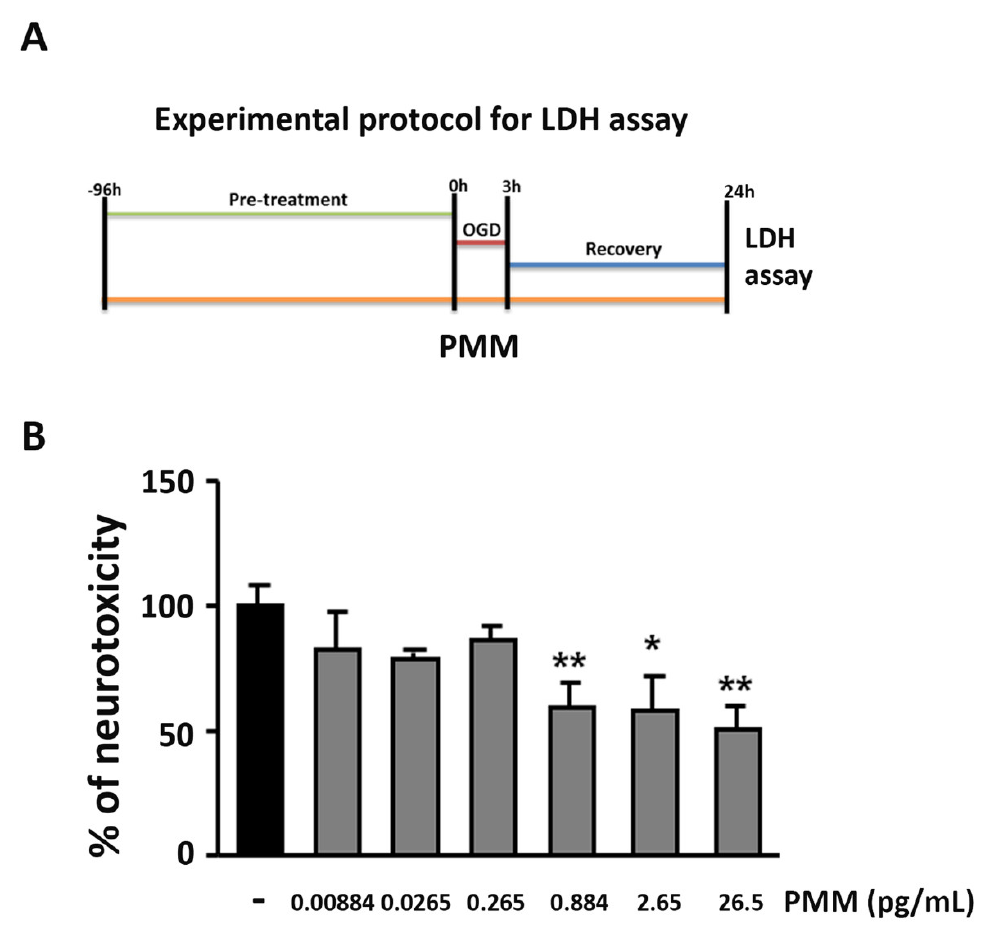
Figure 1. Pre-treatment with the polyphenol-enriched micronutrient mixture (PMM) promotes neuroprotection in cortical neurons exposed to oxygen and glucose deprivation (OGD). ( A ) Experimental protocol for lactate dehydrogenase (LDH) toxicity assay in cortical neurons. Cells were pre-treated with the PMM at day in vitro (DIV) 7. At DIV 11, cells were exposed to 3 h of OGD and then maintained in recovery medium for 24 h. The mixture was renewed at every change of media. ( B ) LDH assay was performed at the end of the 24 h of recovery. Different doses of PMM were used in cells. DMSO was used as vehicle in control cells (neurons exposed to OGD). The neurotoxicity of the PMM-treated neurons is represented as a percentage relative to the neurotoxicity in the vehicle-treated neurons (OGD-exposed neurons), arbitrarily set at 100%. The effective neuroprotective doses of